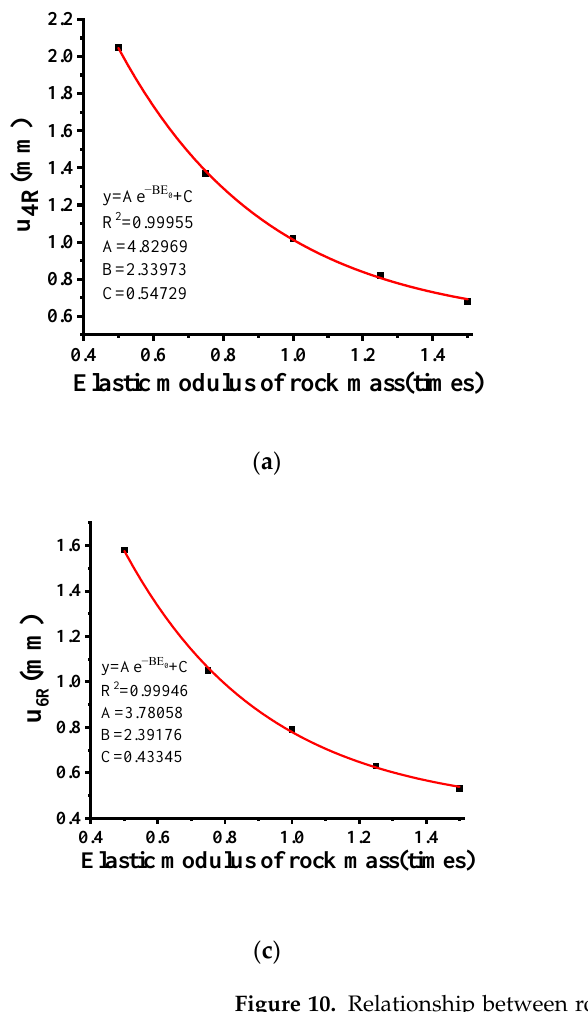
Figure 10. Relationship between rock mass elastic modulus and radial displacement. ( a ) r = 4 R , ( b ) r = 5 R , ( c ) r = 6 R , ( d ) r = 7 R .